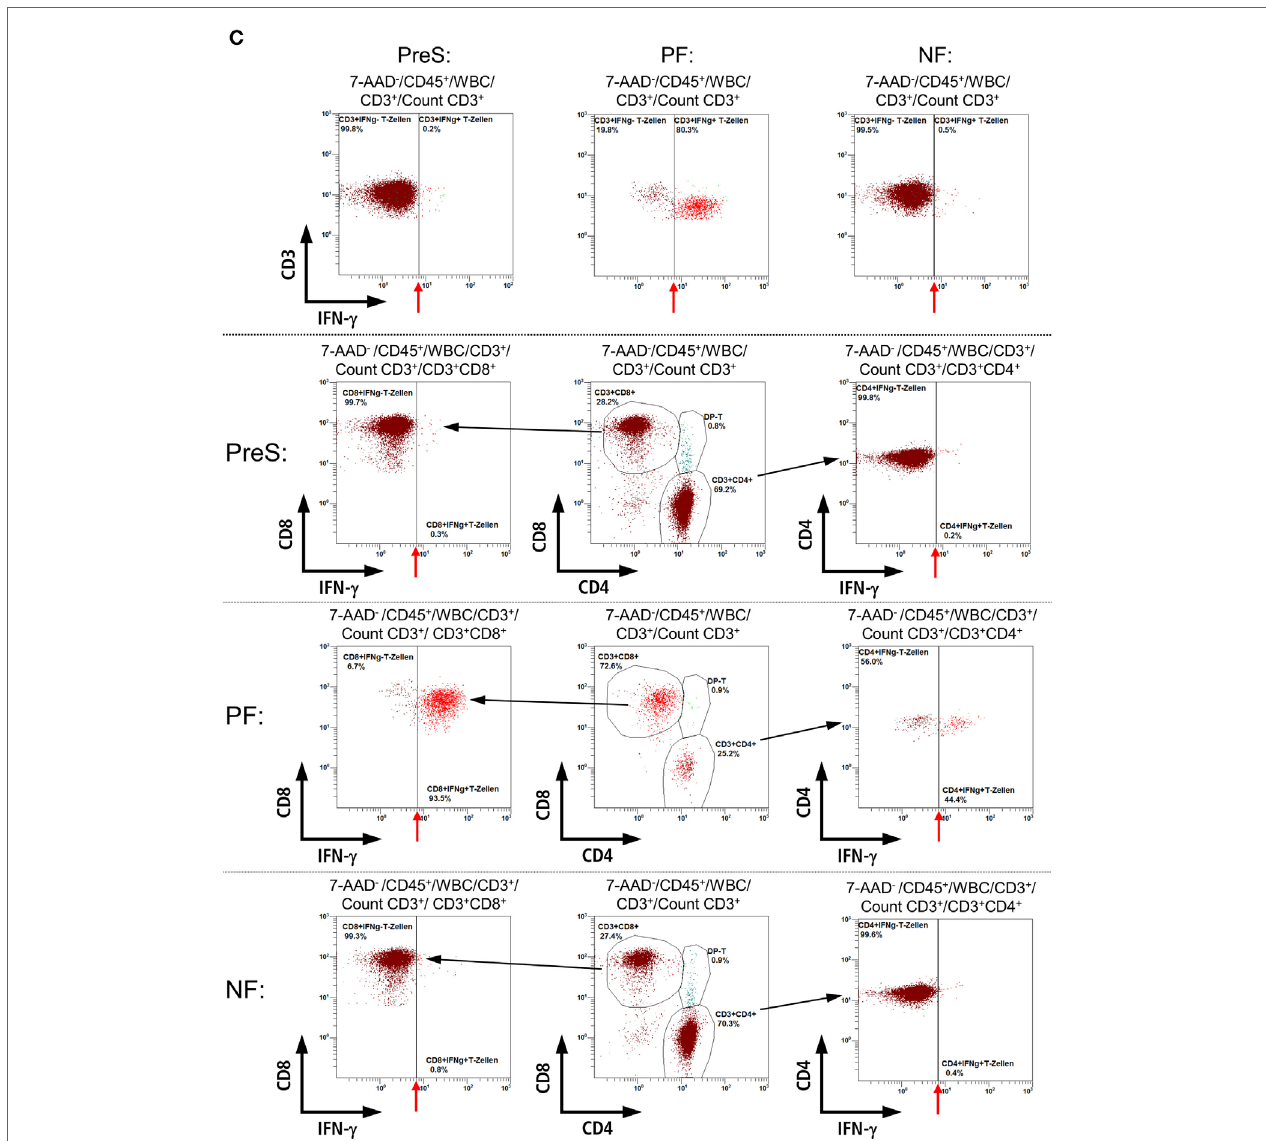
Table 1 . Finally, CD3 negative cell populations of the PreS, PF, and NF fractions of all Prodigy runs displayed a negligibly low content of less than 0.04% of IFN- γ + cells among B and NKT/ NK cells or